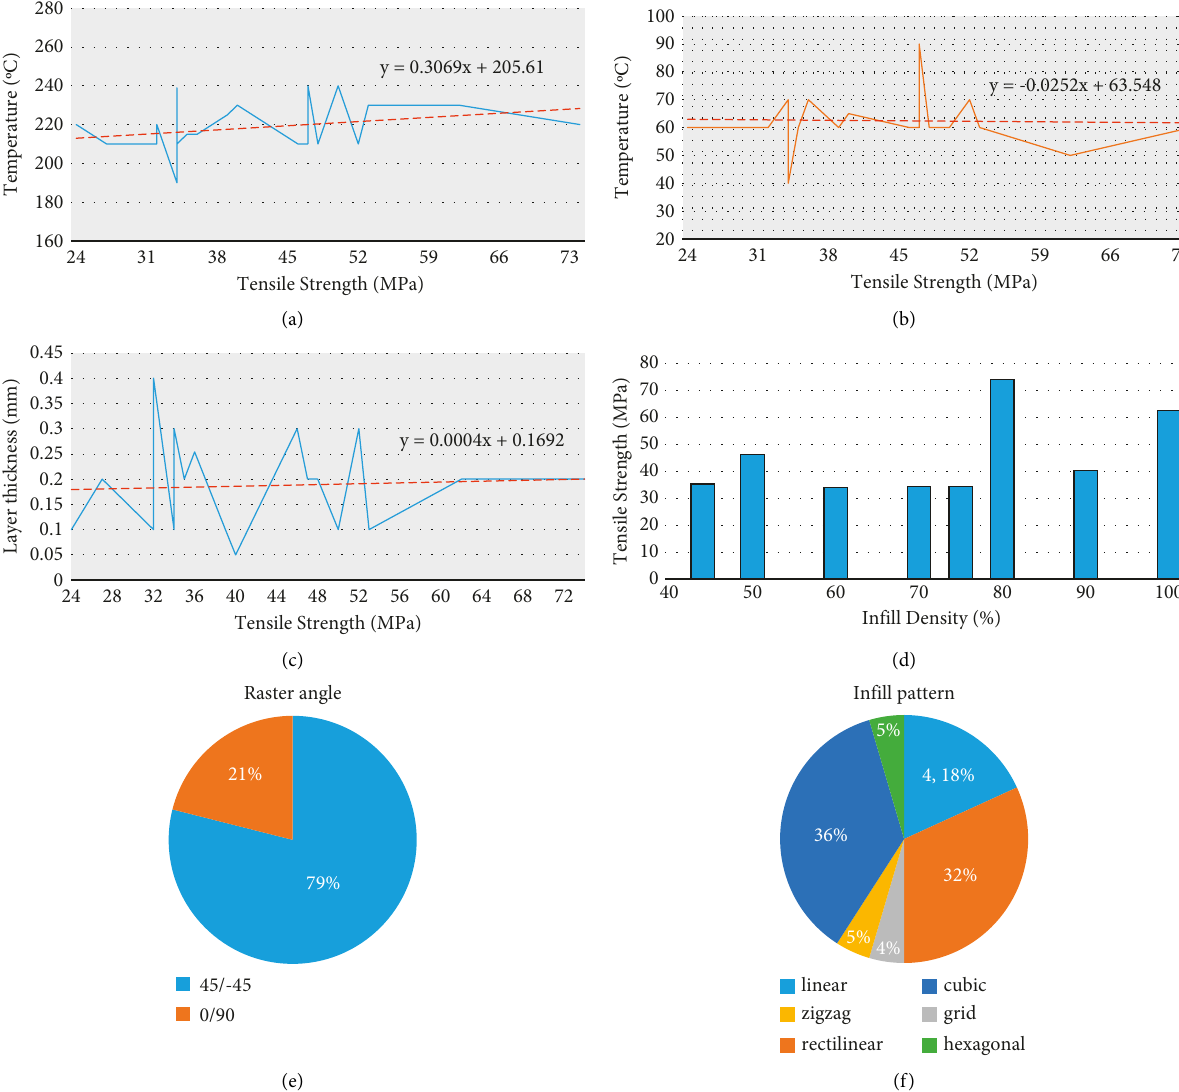
Figure 4: Graphical representation analysis of FDM process parameter value: (a) tensile strength vs. extrusion temperature, (b) tensile strength vs. bed temperature, (c) tensile strength vs. layer thickness, (d) tensile strength vs. infill density, (e) percentage of raster angle works for 45/ 45 ° , and 0/90 ° , and (f) percentage of infill pattern works for linear, grid, cubic, rectilinear, zigzag, and hexagonal −